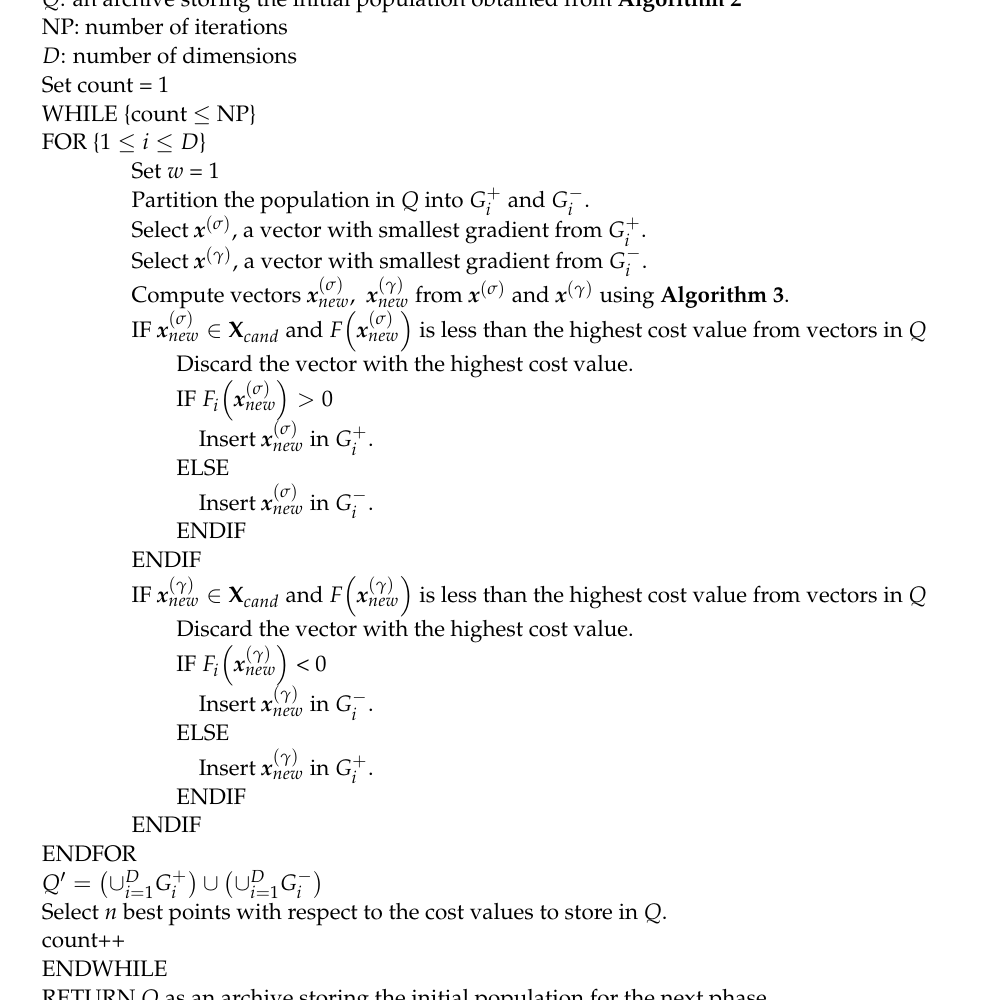
Algorithm 4 Generating a population using the opposite gradient method